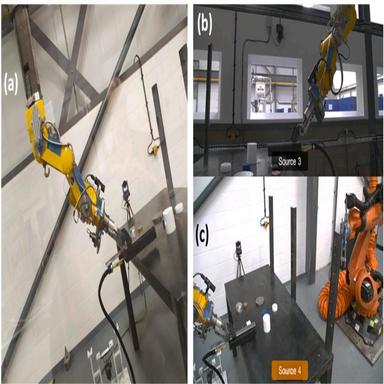
Stand-off Raman probe (a) Making a measure measurements in the simulated active hot cell window view, (b) & (c) view from control room during the day time.